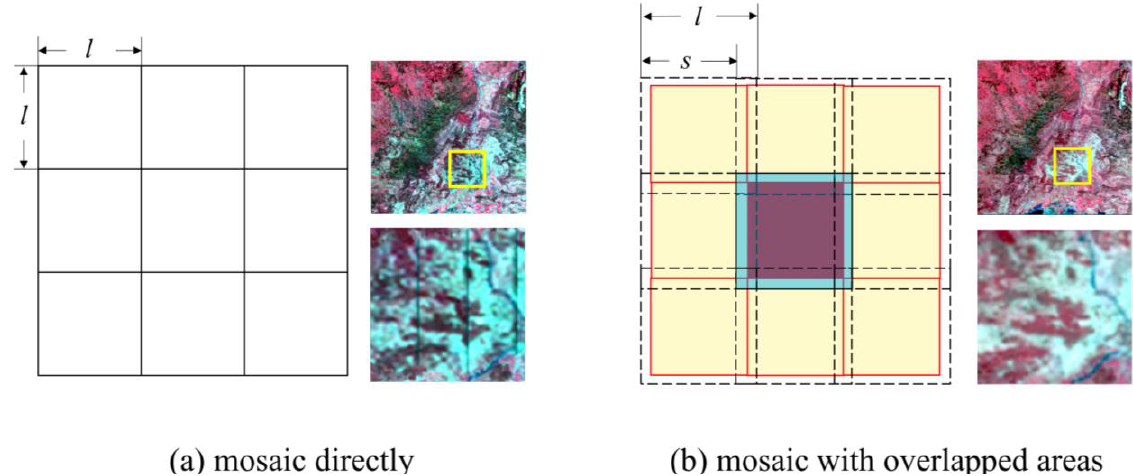
Figure 13. The comparison for images to process large images using the methods that ( a ) mosaic image patches directly, and ( b ) mosaic image patches with overlapping areas in the edges.